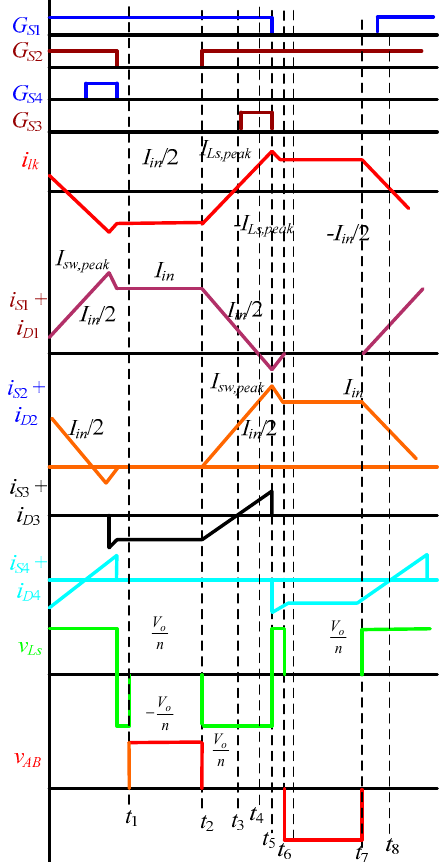
Figure 2. Operating waveforms of the ZCS current-fed converter shown in Figure 1. Reproduced with permission from [17], IEEE, 2020.